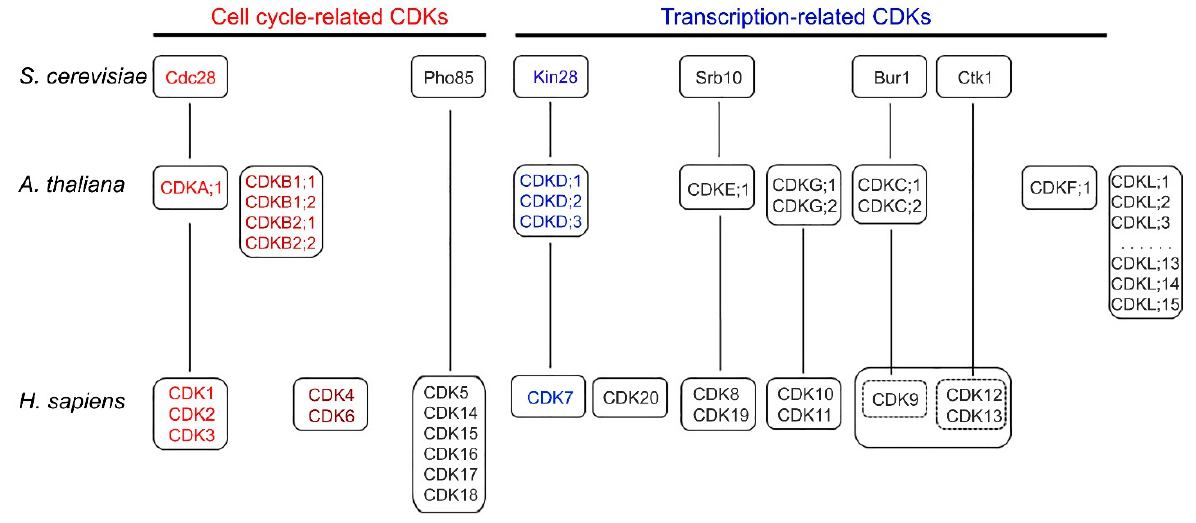
Figure 2. Groups of CDKs from yeast ( S. cerevisiae ), Arabidopsis ( A. thaliana ), and human ( H. sapiens ). Note that Arabidopsis contains 15 CDK-like genes (CDKL1 to CDKL15). The vertical line indicates an orthologous relationship. CDKs in color represent the two major regulators that are involved in cell cycle and transcriptional control.